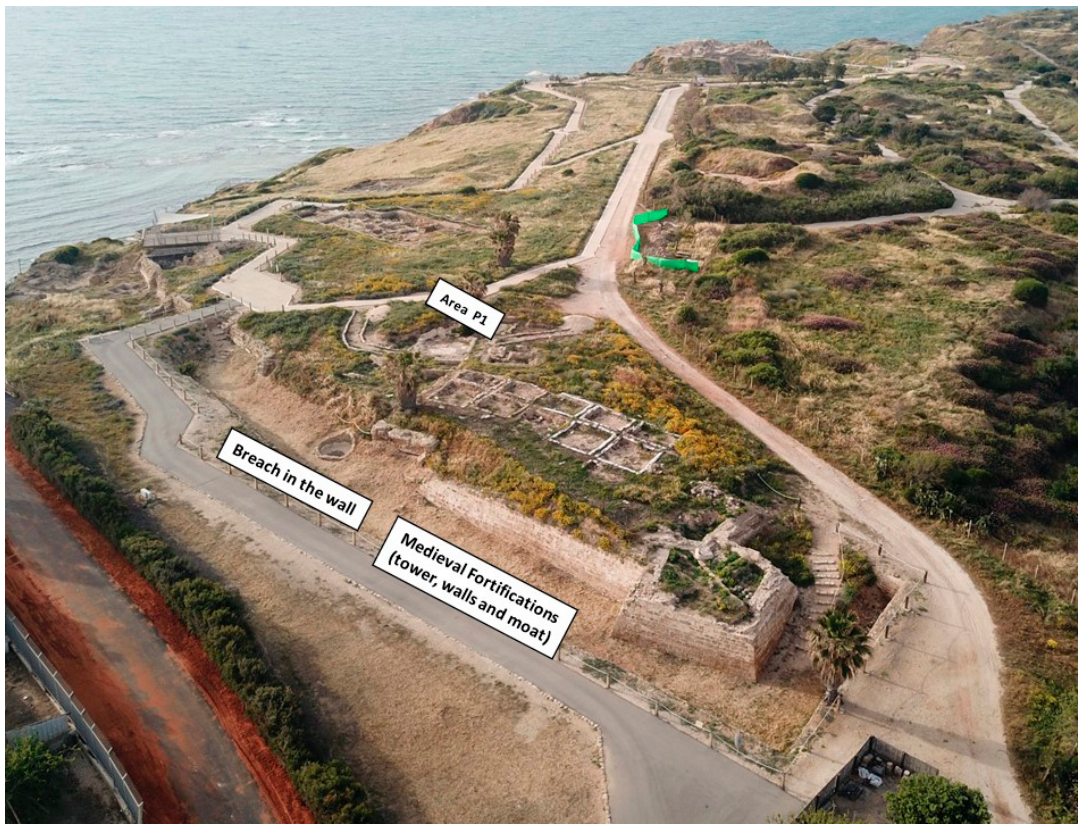
Figure 3. Apollonia-Arsuf, aerial photograph of the medieval walled town southern section (with indication of the southern fortifications and Area P1) (Or Fialkov).